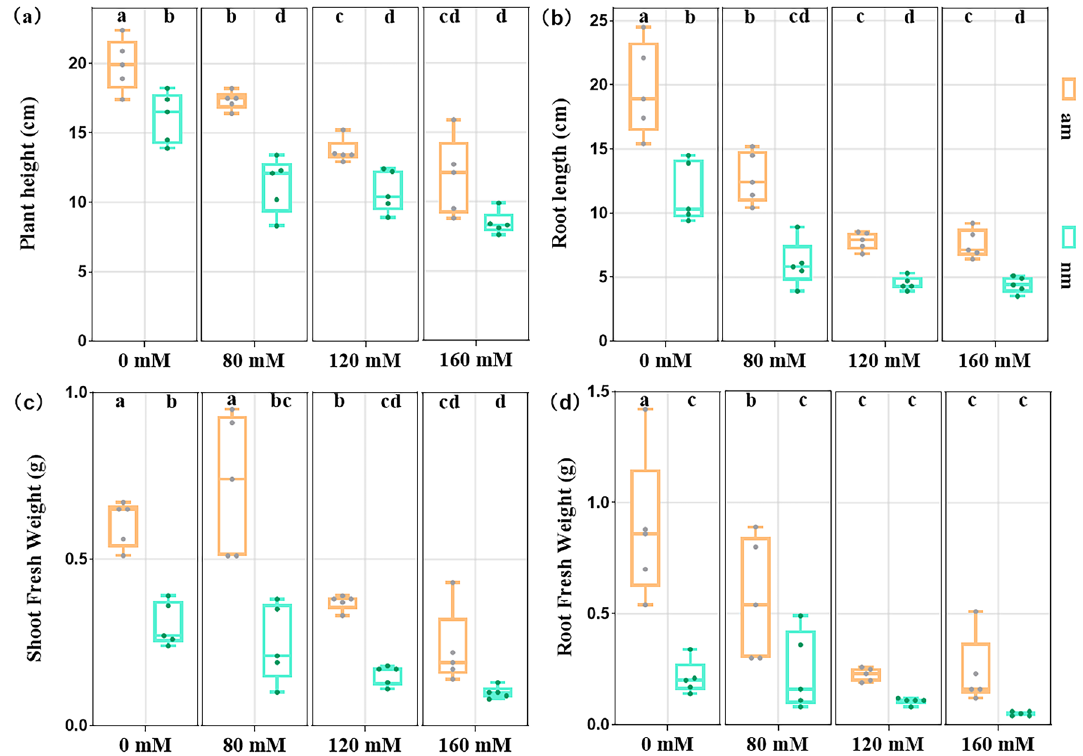
Fig. 3 Growth parameters of Oryza sativa L . in different treatment groups. Note: a plant height; b root length; c shoot fresh weight; d root fresh weight. The results are presented as the mean standard deviation of three replicates. Different letters indicate the difference between different ± treatment groups ( P <